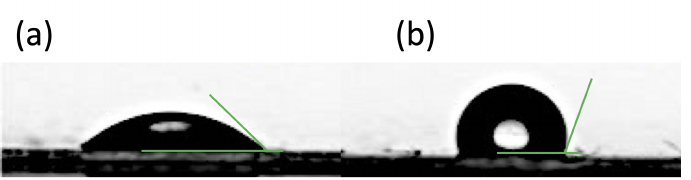
Figure 10. Contact angle of a water drop on ( a ) a polymer surface with medium surface energy ( θ = 44 ◦ ) and ( b ) a polymer surface with low surface energy ( θ = 110 ◦